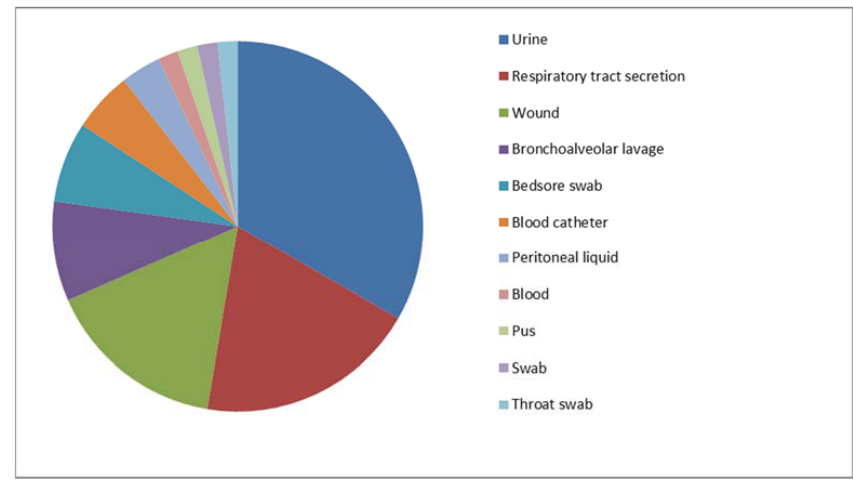
Figure 4. The origins (specimen types) of the multidrug ‐ resistant P. aeruginosa strains included in the study ( n = 57).